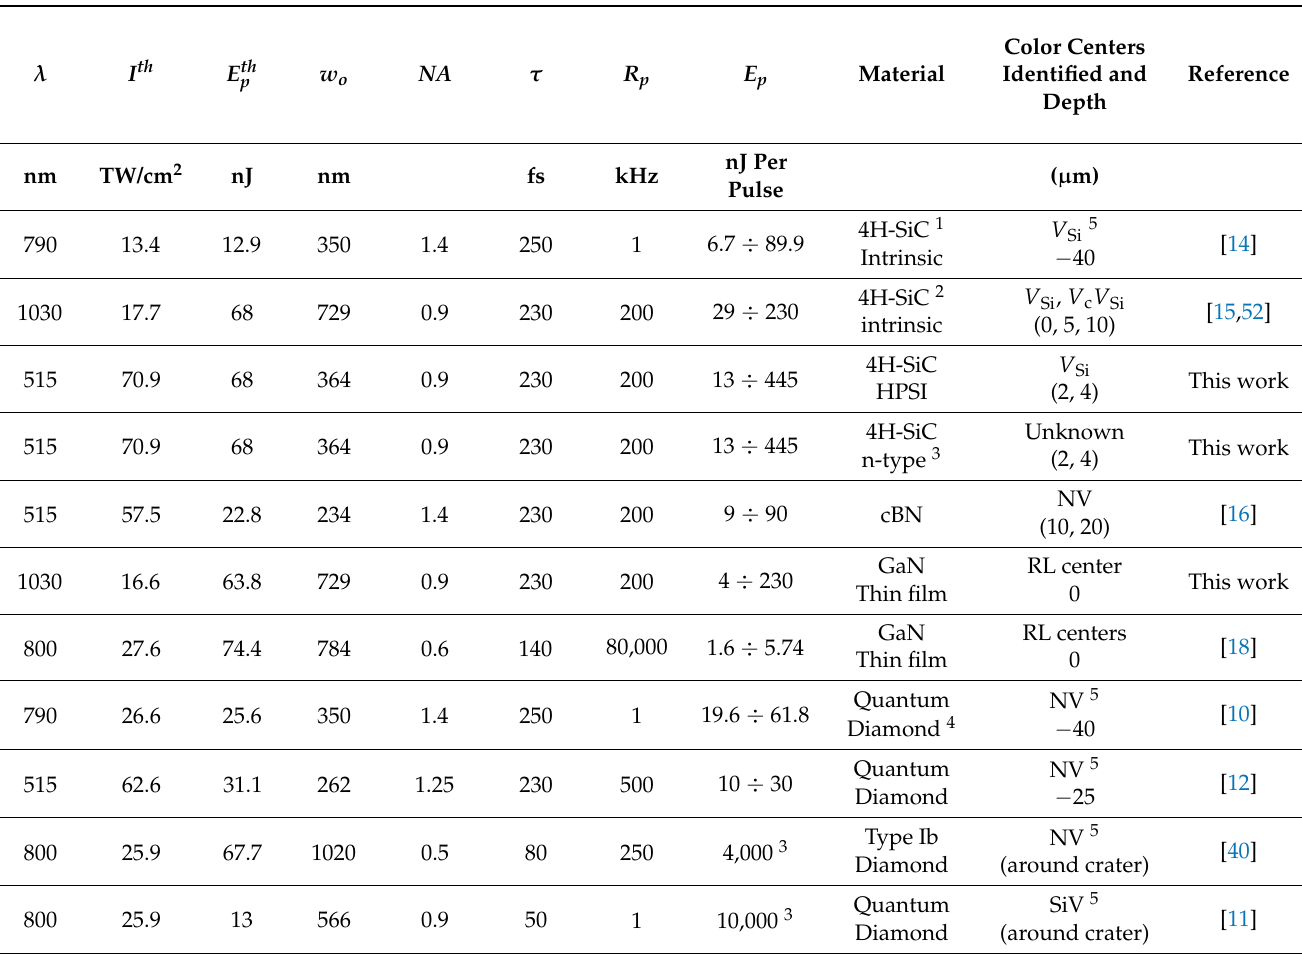
Table 2. Laser fabrication conditions for various experiments with laser wavelength λ , waist w o , objective numerical aperture NA , theoretical pulse energy and laser irradiance determining MPI ( E th p and I th ), laser pulse width and repetition rate, τ and R p , respectively, energy per pulse used in the experiments, and E p , material type and color centers generated with depth localization.